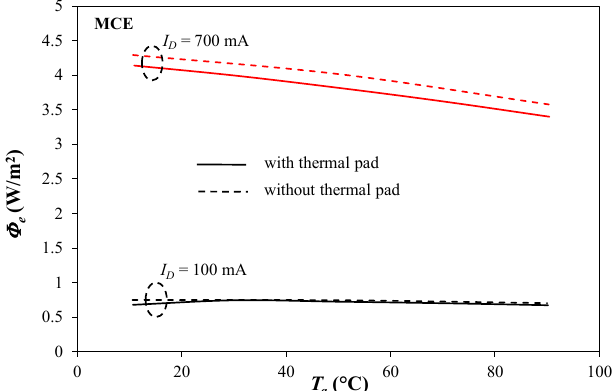
Figure 12. Measured dependences of the surface power density Φ e of the diodes MCE on temperature of the cold plate.